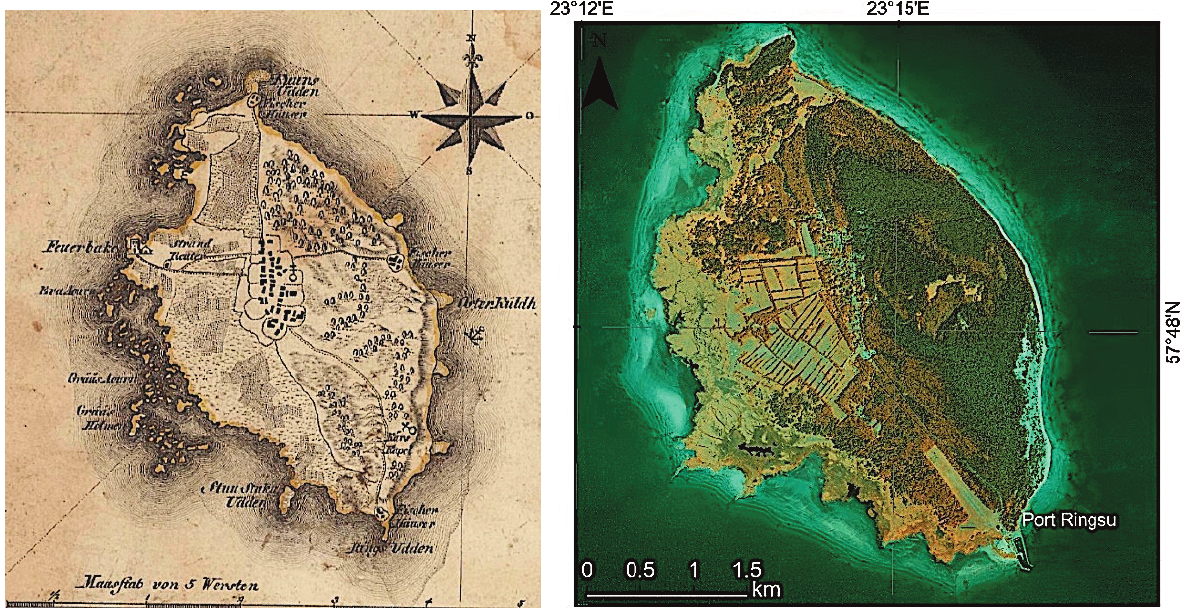
Fig. 2. The island of Ruhnu from the Atlas of Liefland (Livonia) by Ludwig August von Mellin in 1798 (left panel). It is likely that boat landing sites were located by the fishermen’s houses (Fischer Häuser). Note that the fishermen’s house near Cape Ringsu (Rings- Udden) was located on the western coast of the cape, which is open to one of the predominant wind directions. The Port of Ringsu is located at the south-eastern tip of the island (right